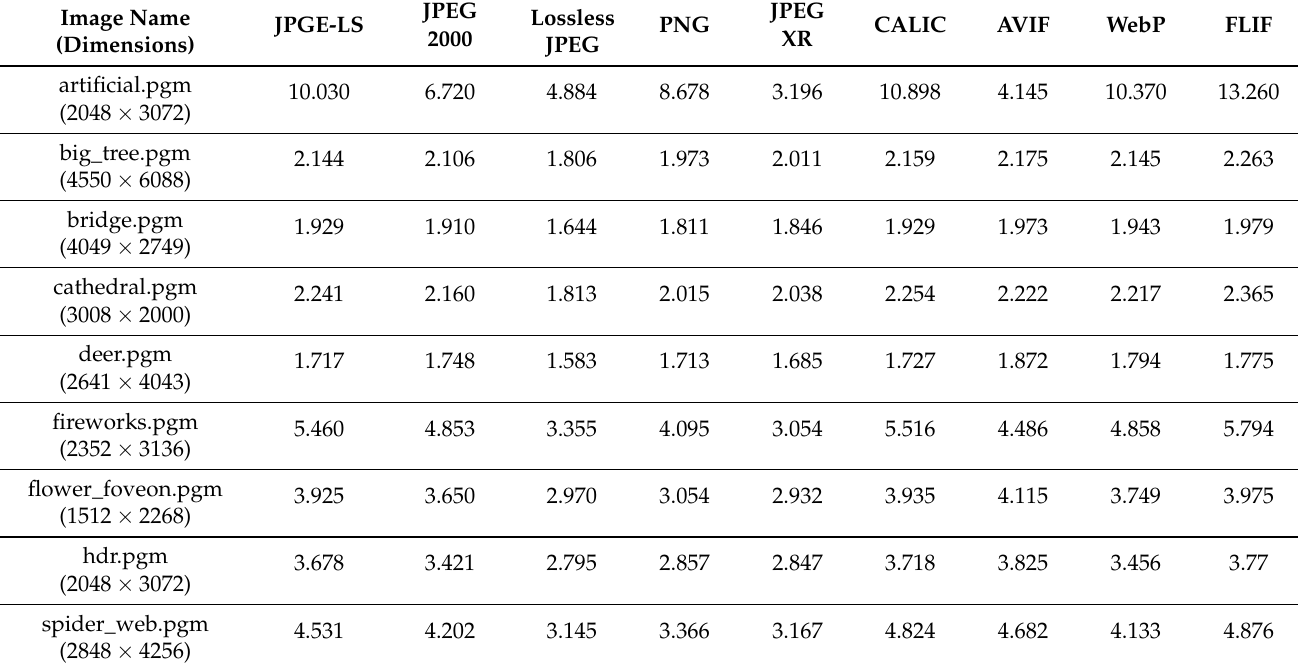
Table 5. Comparison of compression ratios for 8-bit greyscale